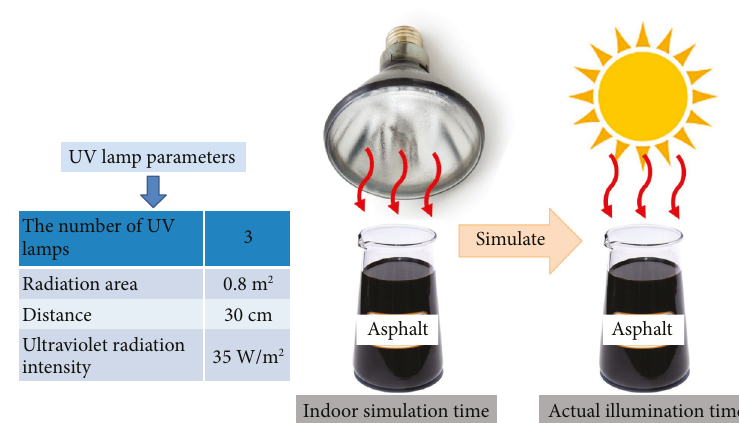
Figure 3: UV aging testing facility.